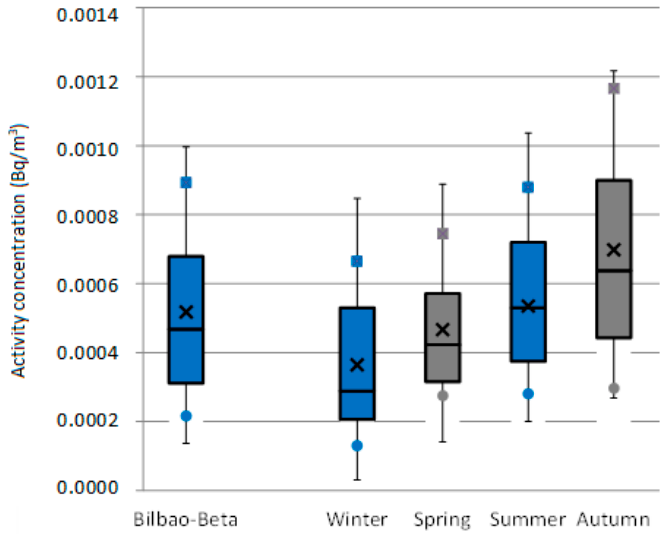
Figure 7. Total and seasonal box-whisker plots for beta activity concentrations over the period 2014–2018 in Bilbao. The rectangle represents the 50% of data (interquartile range from 25th (P25) to 75th (P75) percentile), the small cross identifies the mean, the continuous horizontal line inside the rectangle identifies the median (50th percentile, P50), the squares and circles identify the 90th (P90) and 10th (P10) percentiles, respectively, and the whiskers extend between the 95th (P95) and 5th (P5) percentiles.